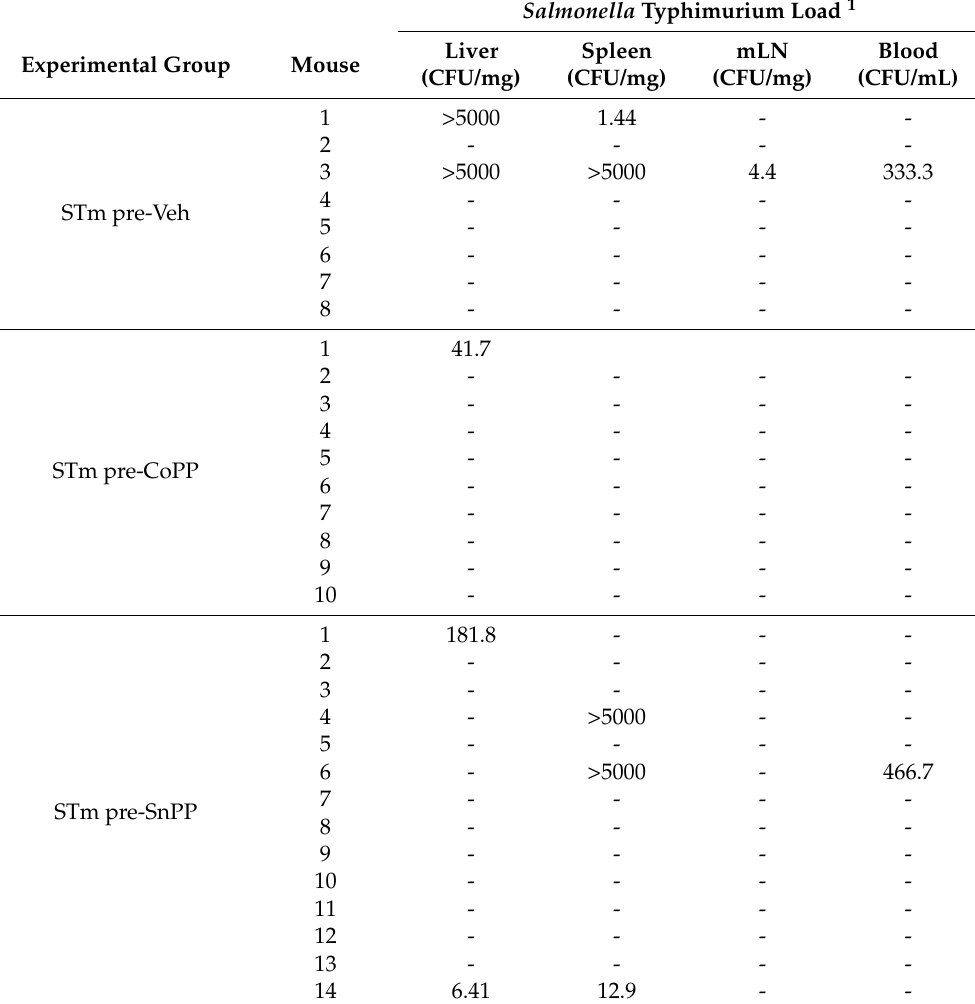
Table 1. S. Typhimurium load in mice organs after prophylactic treatment with CoPP.